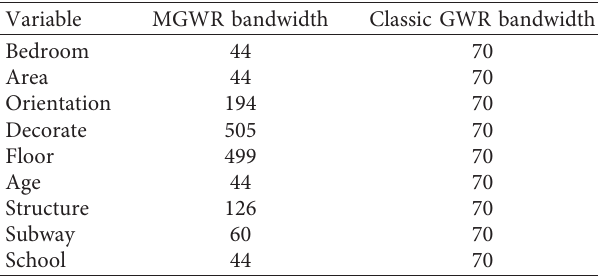
Table 4: Bandwidth of classical GWR and NGWR models.